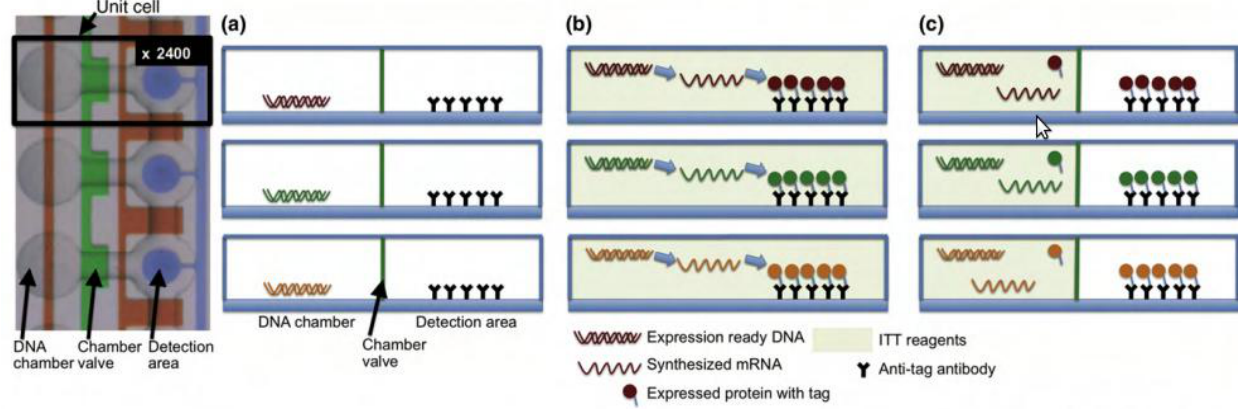
Figure 5. DNA to protein arrays microfluidic platform. ( a ) DNA templates are enclosed on each unit chamber, while the detection area contains immobilized antibodies. ( b ) To generate the DNA to protein array (DTPA) the device is loaded with the in vitro transcription/ translation (ITT) reaction mixture, allowing for protein synthesis to occur. ( c ) The detection area is washed to remove any ITT leftovers, and the protein array is now ready for further analysis. Reprinted with permission from [123], Copyright (2010) Elsevier